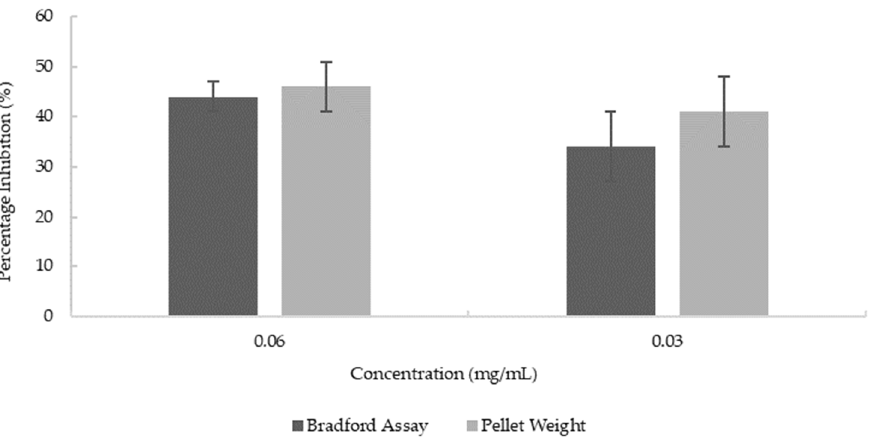
Figure 6. Reduction in the synthesis of AChE at various concentrations of blueberry extract. Values are presented as the mean ± SD; n = 4 for the pellet weight method and n = 6 for the Bradford assay. The cholinergic system plays an important role in many forms of dementia, including AD. The deficit in cholinergic transmission could affect cognition and behavior, leading to dementia [48]. Inhibition of AChE/BChE could counter the cholinergic deficit and im- prove cognition [14,49]. In addition to directly contributing to the cholinergic deficit, AChE is at an elevated level in amyloid plaque and neurofibrillary tangles regions, sug- gesting AChE can modulate the A β precursor protein processing and production, partic- ularly in a degenerative cycle that enhances A β precursor protein processing, leading to the formation of amyloid plaques [10]. Our results on the dual inhibition of AChE/BChE and reduced AChE biosynthesis by blueberries (at low mg/mL fresh berry equivalent) provide the basis that blueberries play important roles in improving cholinergic signaling, and potentially modulate the A β precursor protein processing and production. 3.5. Anti-Amyloidogenic Property Amyloid aggregation is associated with several degenerative diseases affecting the brain or peripheral tissues. Amyloid aggregation in the brain is one of the main hypothe- ses for AD [8,50]. To examine the effects of blueberries on amyloid fibril formation, we used HEWL as a model. It is well known that HEWL solution forms amyloid fibrils in acidic conditions with high temperatures [35,51]. Thioflavin T (ThT) is among the widely used fluorescence probes for selectively staining and identifying amyloid fibrils both in vivo and in vitro by strong fluorescence at 490 nm upon binding to amyloid fibrils. How- ever, most polyphenols absorb the light around 490 nm and significantly quench ThT’s fluorescence [52,53]. Our own data also showed blueberries quench ThT fluorescence at 490 nm dramatically (data not shown). Therefore, using ThT to monitor the inhibition of the amyloid aggregation by polyphenols will generate bias and false positive results. Congo red is widely used as a stain to amyloid fibrils and the binding to amyloid fibrils leads the CR absorption to a red shift with a unique shoulder peak near 540 nm [54]. As shown in Figure 7A, following agitation (170 rpm) and elevated temperature (70 °C) at low pH (pH 2.0 glycine buffer), the aged HEWL induced the absorbance of CR to a longer wavelength with the appearance of the secondary peak at 536 nm indicated the formation of amyloid fibril. Hence, the secondary peak of CR following binding to amy- loid fibril at 536 nm was used to detect the amyloid formation. Figure 7B,C show the CR spectra with HEWL alone and that with the blueberry- treated sample in glycine buffer, pH 2.0. It clearly showed that HEWL alone formed am- yloid fibrils after 24 h (day 1) (Figure 7B), while the blueberry-treated sample formed am- yloid fibrils after 48 h (day 2) (Figure 7C). Since fresh HEWL without amyloid fibril does